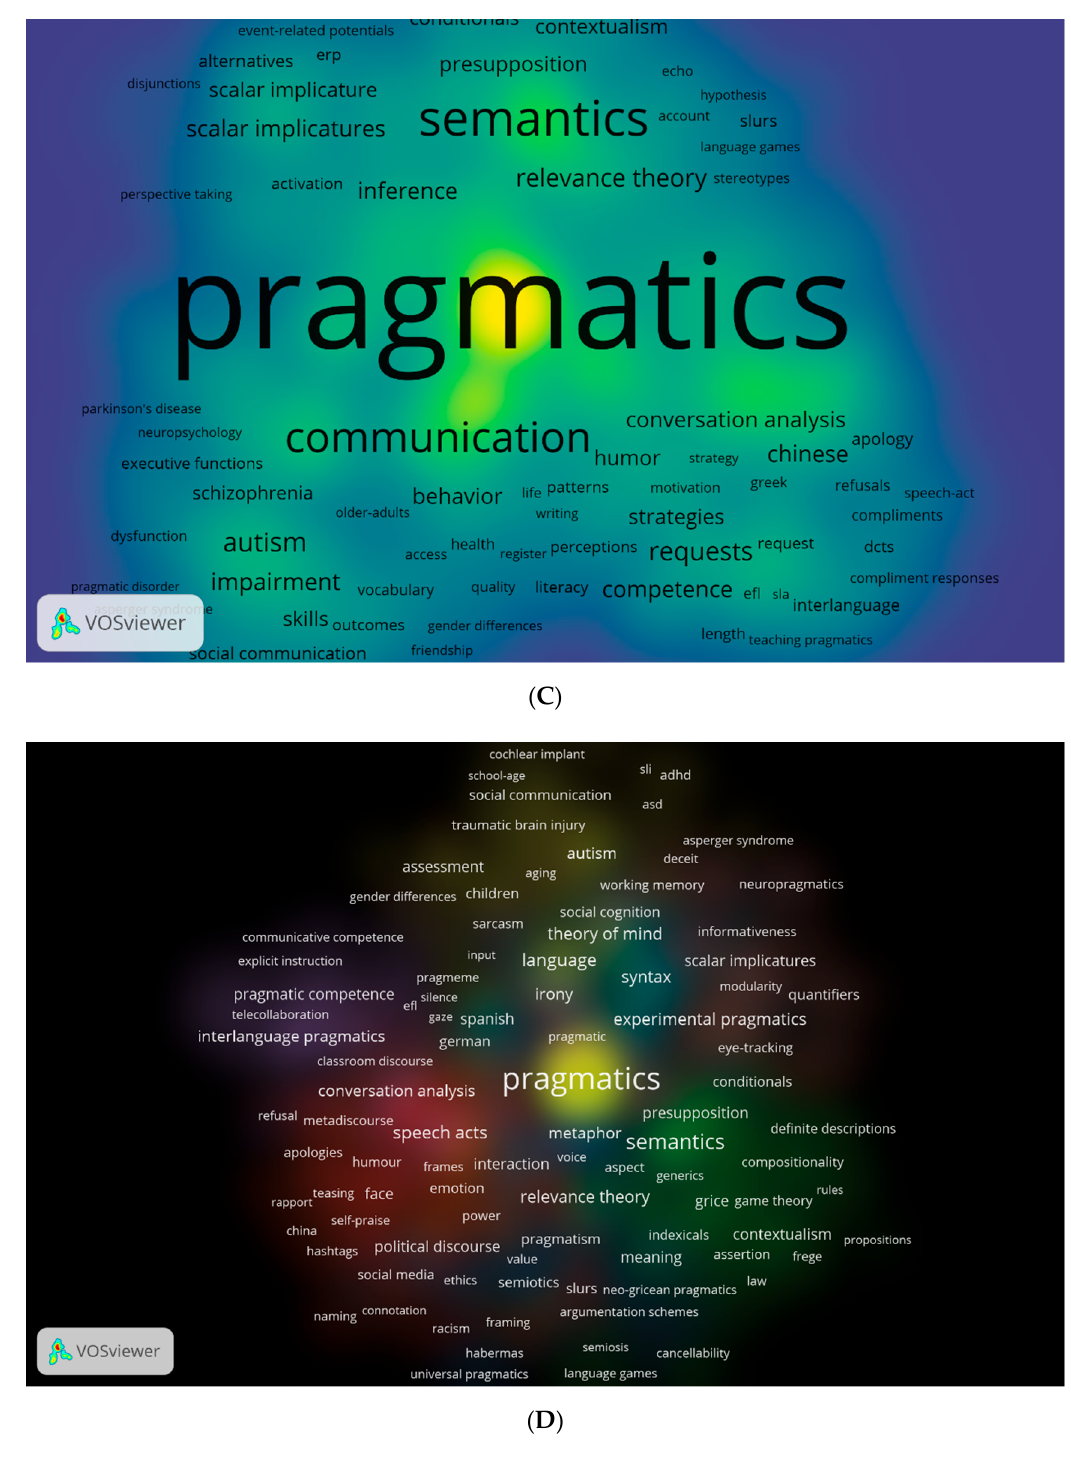
Figure 7. Cooccurrence by keyword network visualisation. ( A ) (Scopus). ( B ) (WOS) author keywords. ( C ) (WOS) cooccurrence by all keyword density visualisation. ( D ) (WOS) cooccurrence by author keyword density visualisation.